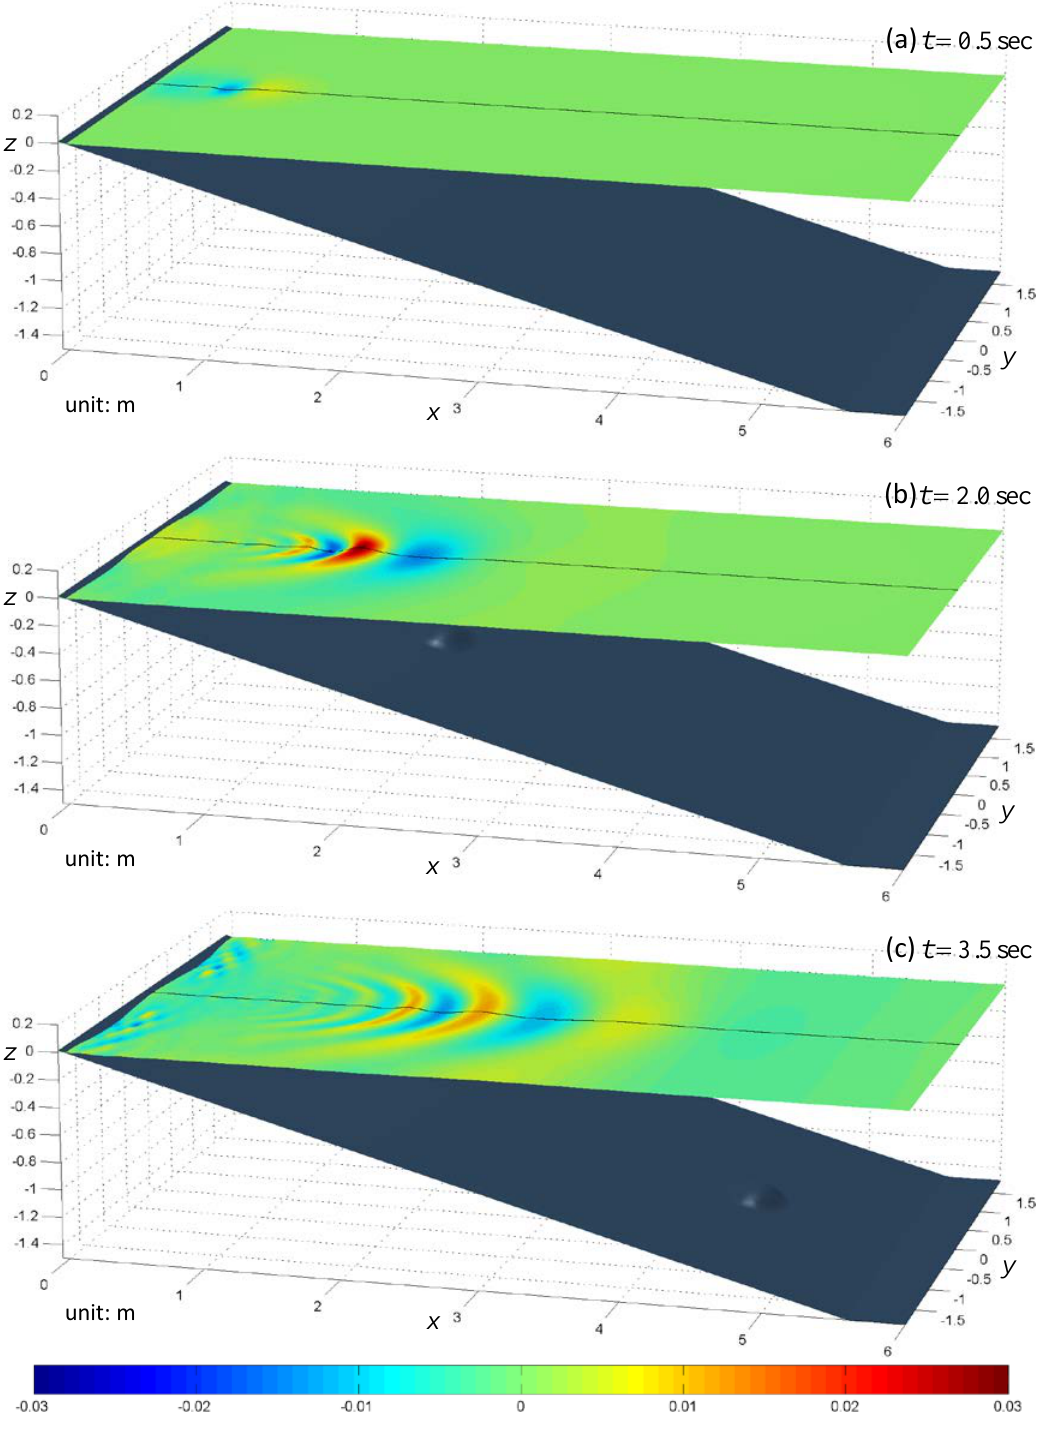
Figure 6. Snapshots of the free surface elevation in case 1. ( a ): t = 0.5 sec; ( b ): t = 2.0 sec; ( c ): t = 3.5 sec.